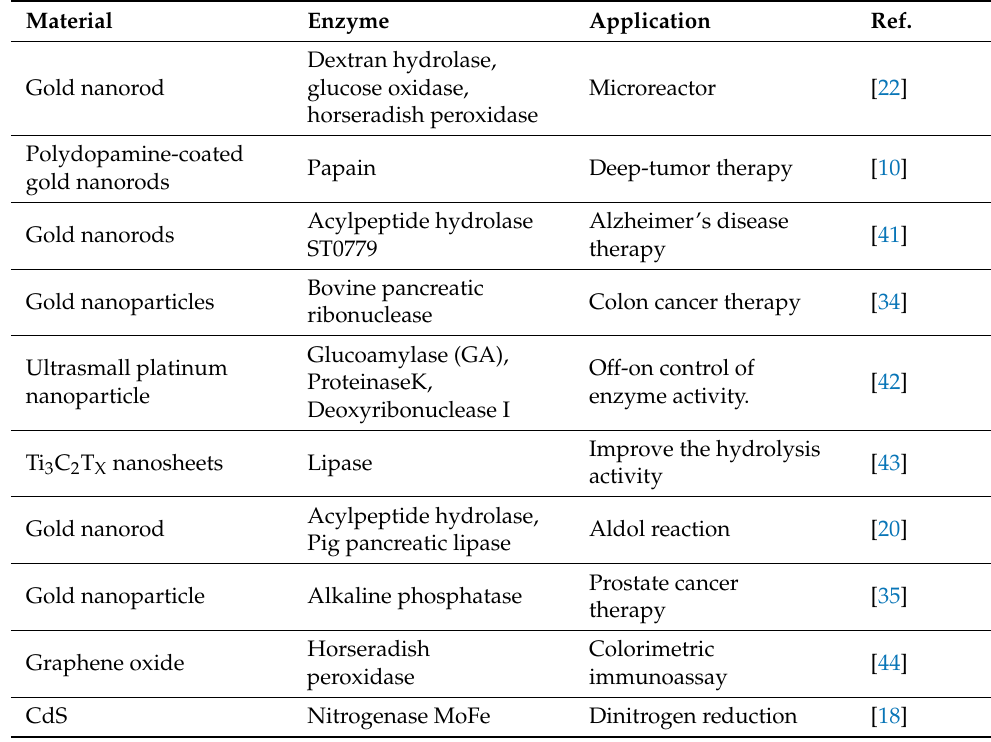
Table 1. NIR-responsive nanoparticles for immobilized enzyme and their applications. Material Enzyme Application